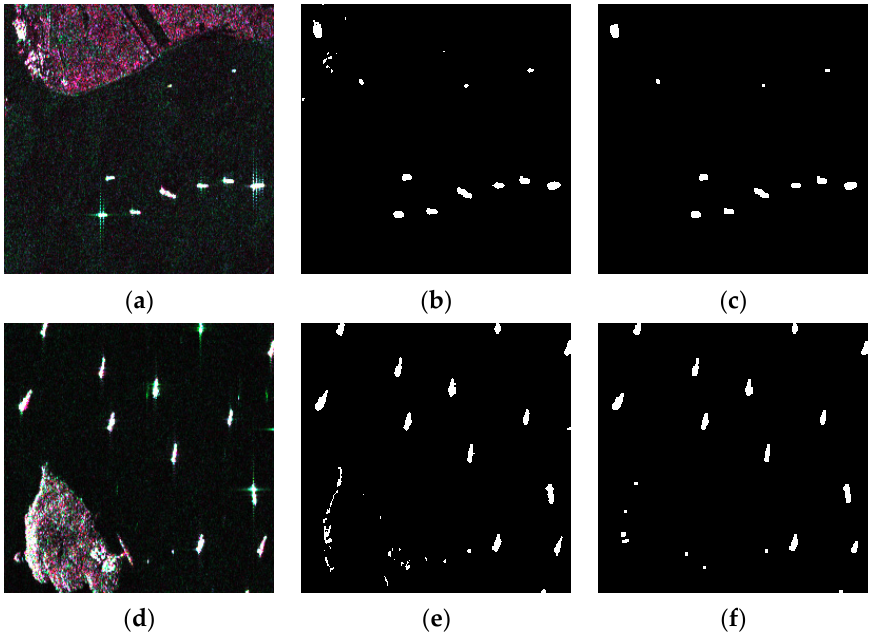
Figure 15. Generation process of binary masks. ( a , d ) are two examples of input; ( b , e ) are binarization results of two-parameter CFAR and become ( c , f ) after morphological transforms.